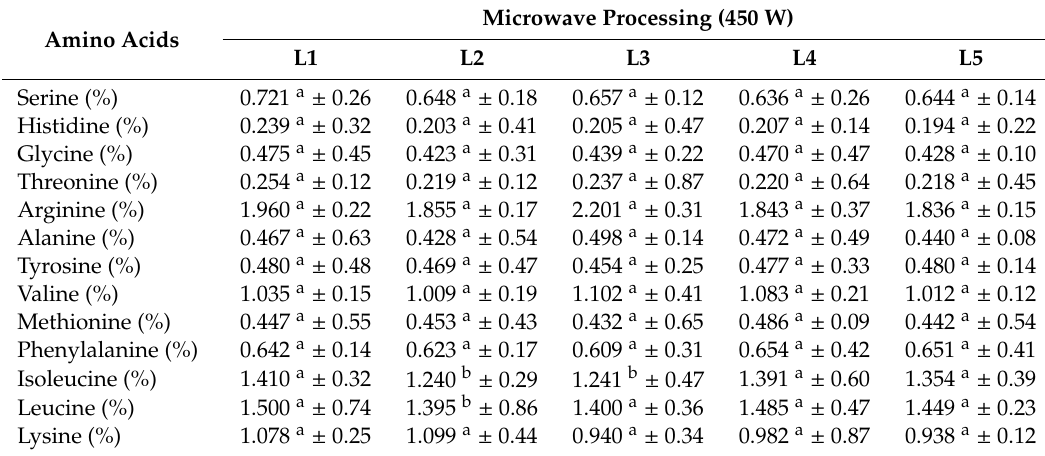
Table 3. Amino acid profile of microwave untreated and treated